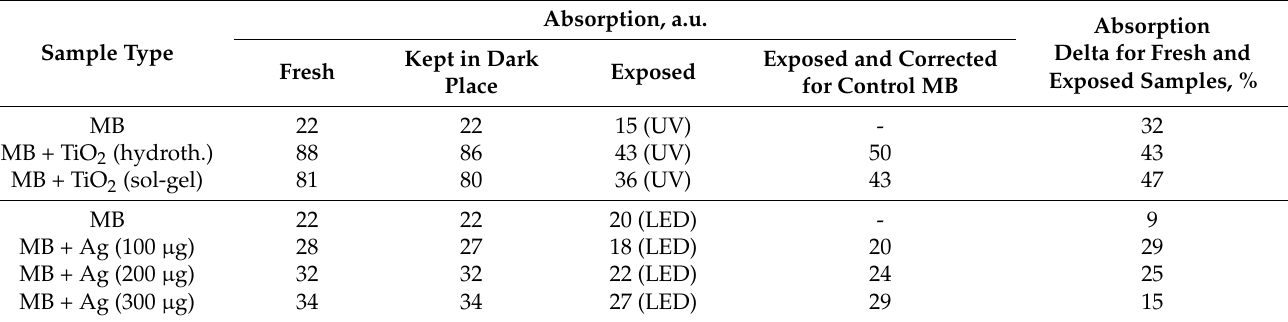
Table 1. Mean absorption band intensity (a.u.) of the MB solutions free of and containing TiO 2 and Ag nanoparticles kept in the dark place or exposed to the UV lamp or LED projector irradiation for 10 min (three measurements were made for each